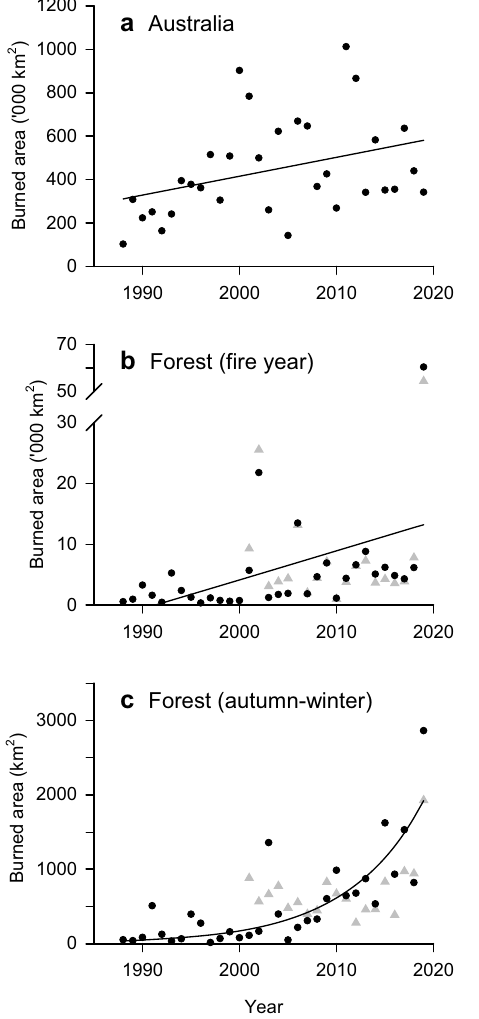
Fig. 1 Burned area (km 2 ) for each fi re year (July to June) from 1988 to 2019. a Whole of continental Australia including Tasmania, linear fi t; ( b ) Australian forests, linear fi t; and ( c ) Australian forests for the Austral autumn/winter seasons (March to August), exponential fi t (regressions in Supplementary Table 1). Data: AVHRR-Landgate (1988 – 2019, dots) and MODIS (2002 – 2019, triangles). Regressions are calculated using AVHRR- Landgate, and MODIS is shown for